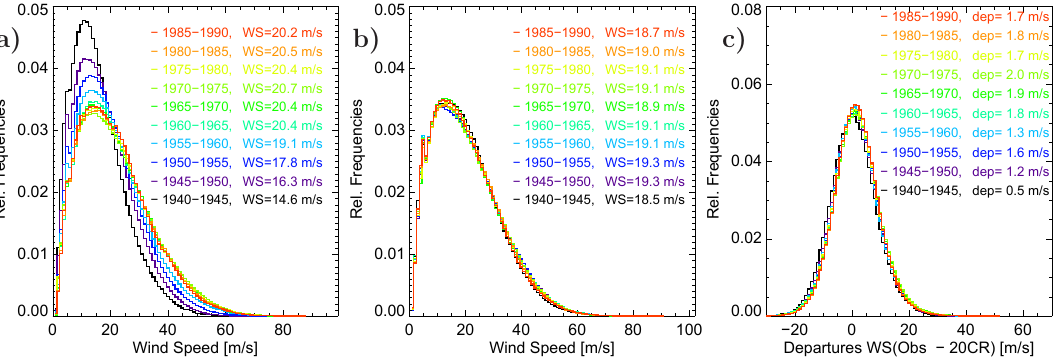
Figure 3. Histogram for several decades of (a) wind speed observations, (b) analyzed wind speeds and (c) innovations (obs-NOAA-20CR) at 300hPa and 00:00UTC for the same subset of stations as in Fig. 12. The histograms have been normalized so that the integral is 1.